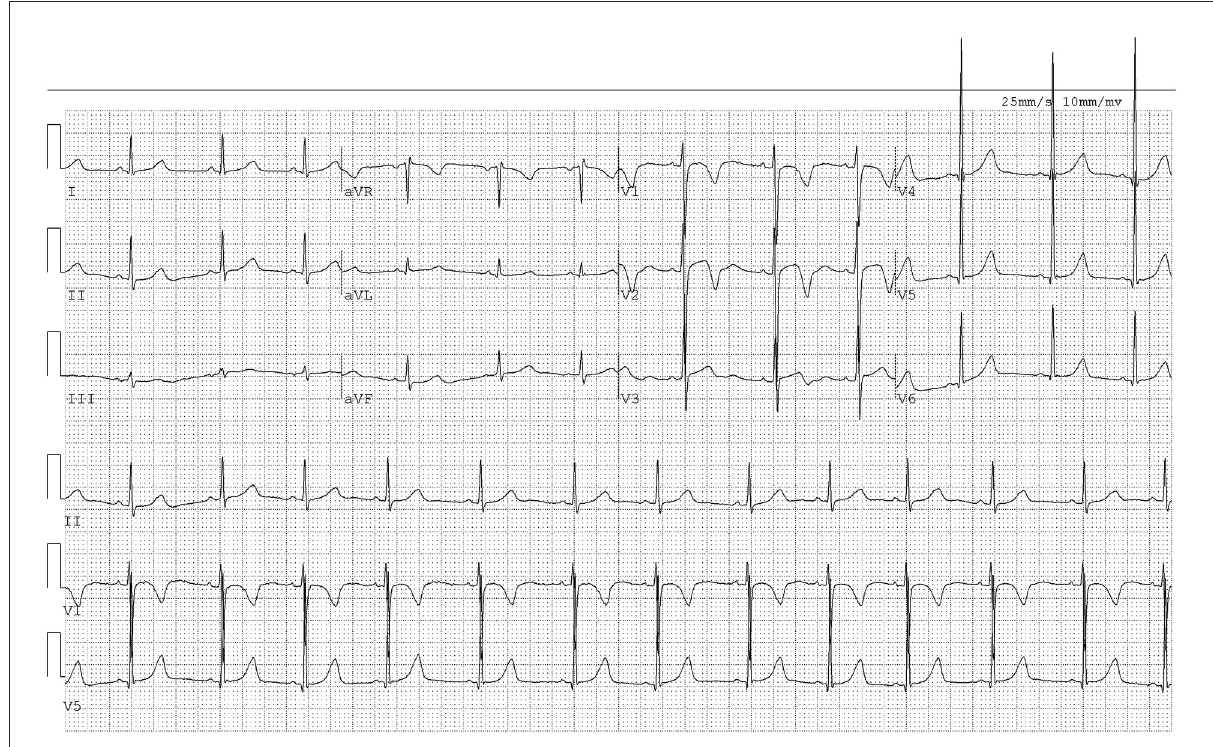
FIGURE4 The ECG of Case 2. The ECG showed sinus arrhythmia.